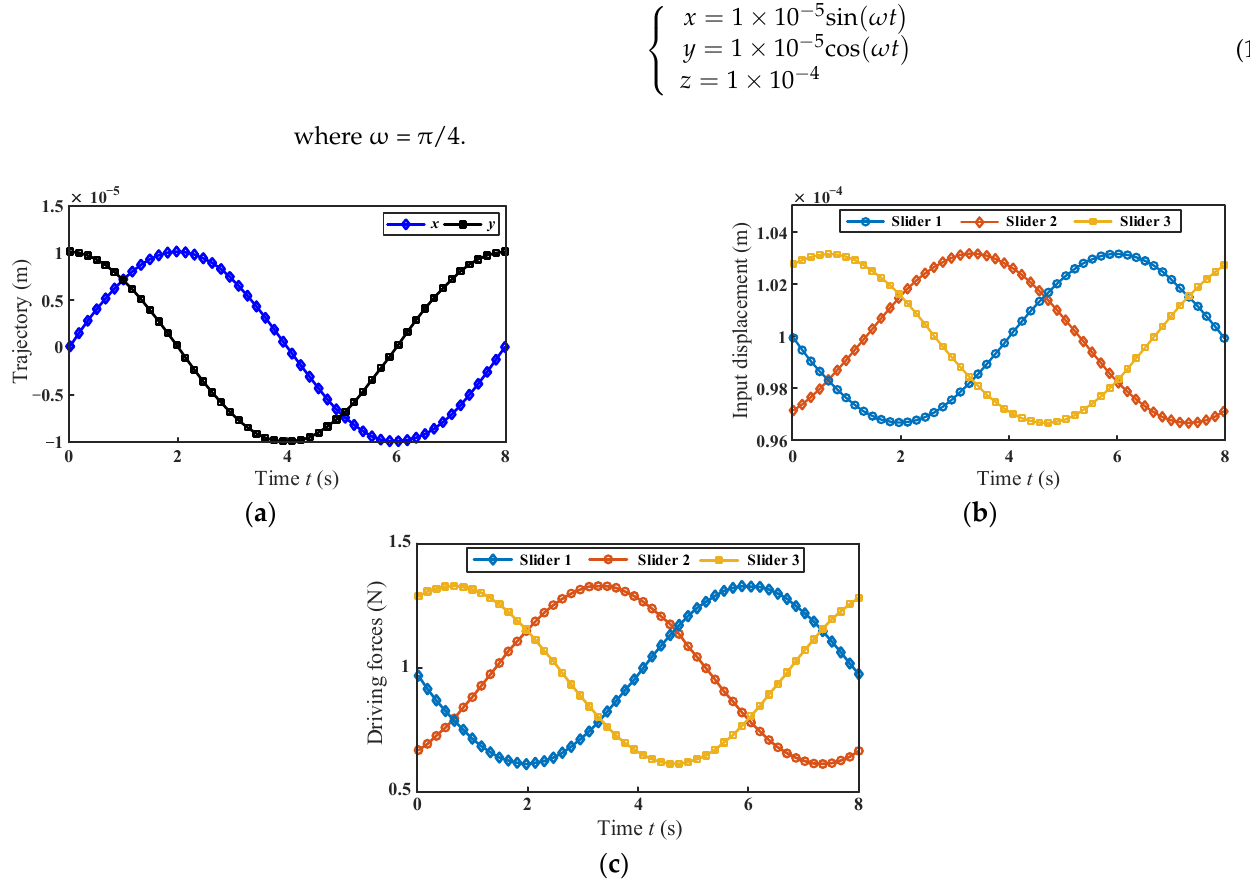
Figure 6. ( a ) Movement trajectory of the moving platform; ( b ) displacements of the sliders; ( c ) the driving forces of the micromanipulator.